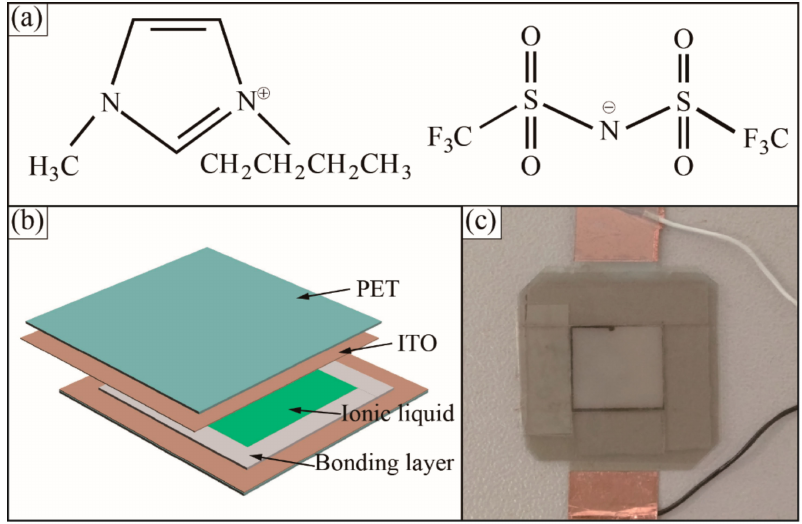
Figure 2. Flexible ionic liquid super-capacitive pressure sensor. ( a ) Chemical structure of ionic liquid. ( b ) Schematic diagram of the flexible sensor. ( c ) Actual fabricated flexible ionic super-capacitive pressure